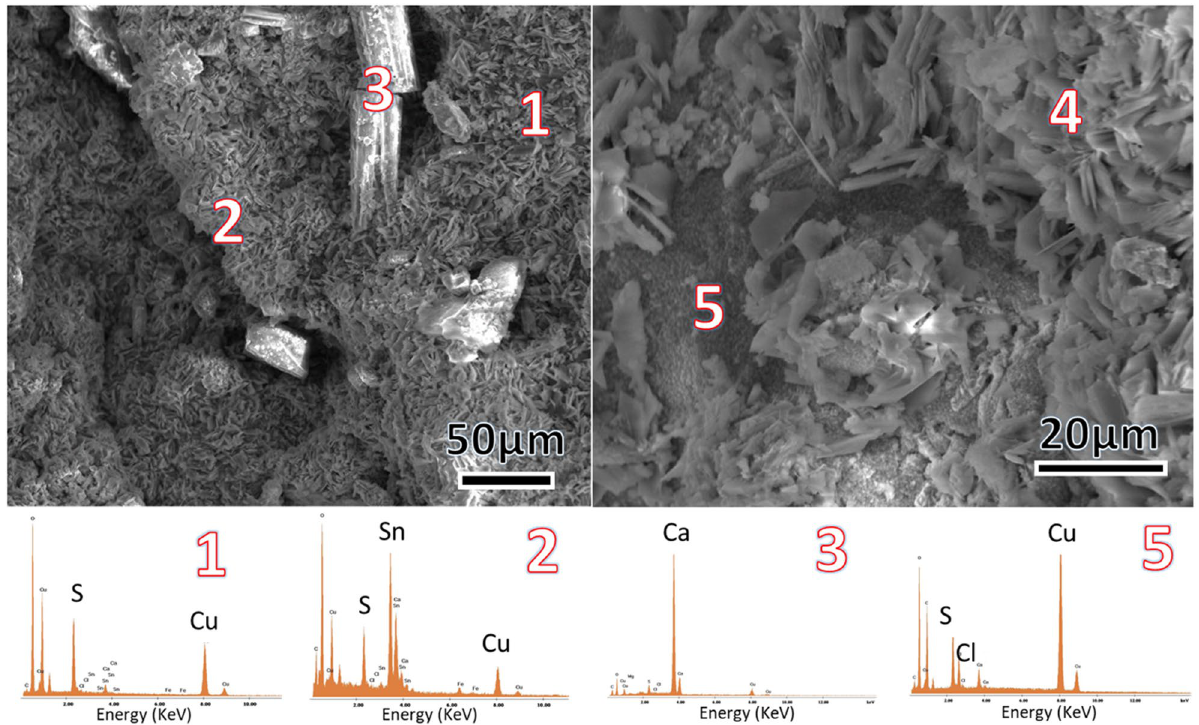
Figure 8. SEM micrographs of a small fragment detached from helmet 2 and EDS analysis of indicated